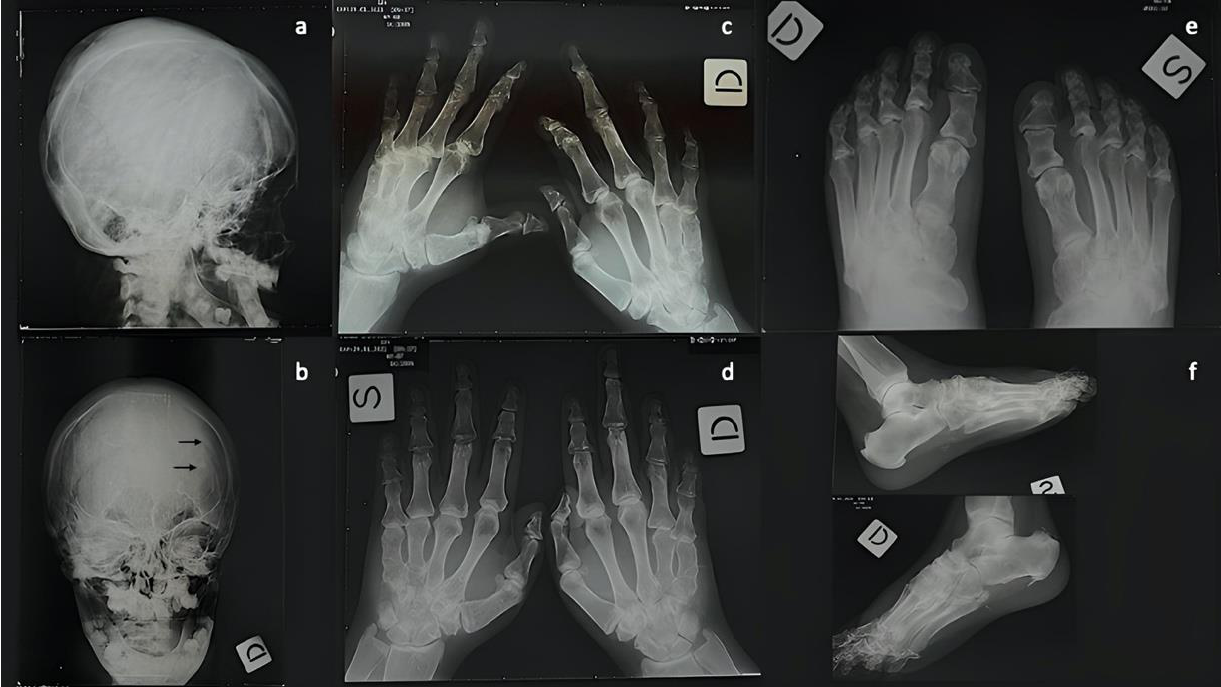
Figure 2. Radiologic findings of the patient. ( a , b ) X-ray of the skull, ( c , d ) X-ray of the hands, ( e , f ) X-ray of the feet.